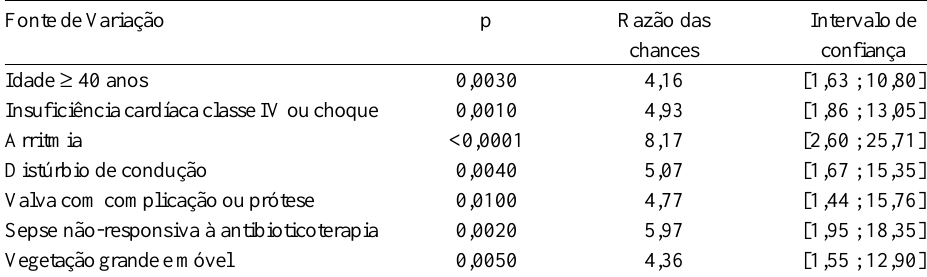
Tabela 3. Mortalidade em análise multivariada